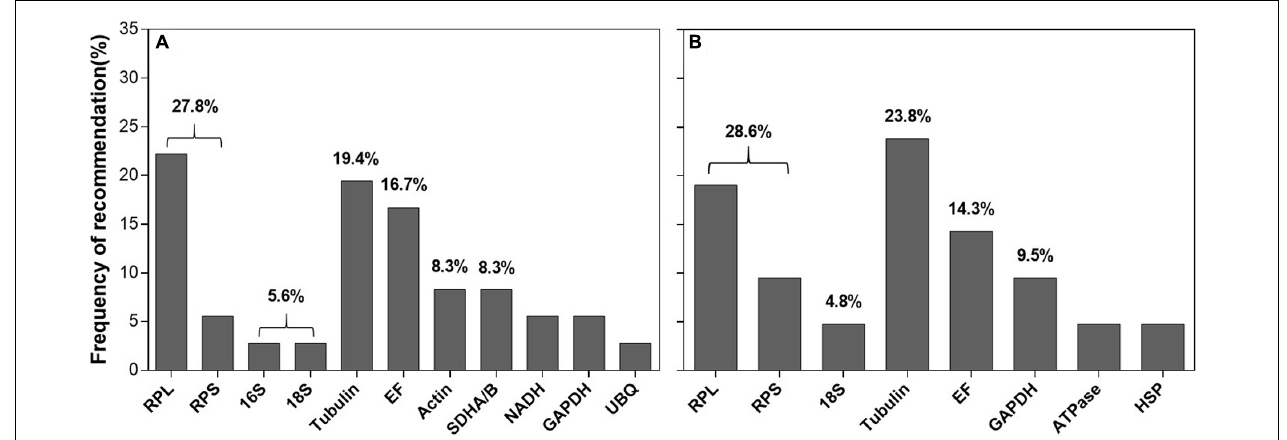
FIGURE 5 | Frequency of reference genes recommended for the cell-content feeding arthropods. Here we surveyed the frequency of each reference gene recommended under different temperature among the twelve cell-content feeding species (A) and different host plants (or diet) among seven cell-content feeding species (B) . Reference genes (top three) recommended for each species under different temperature and host plant are detailed in Supplementary Table S3 .